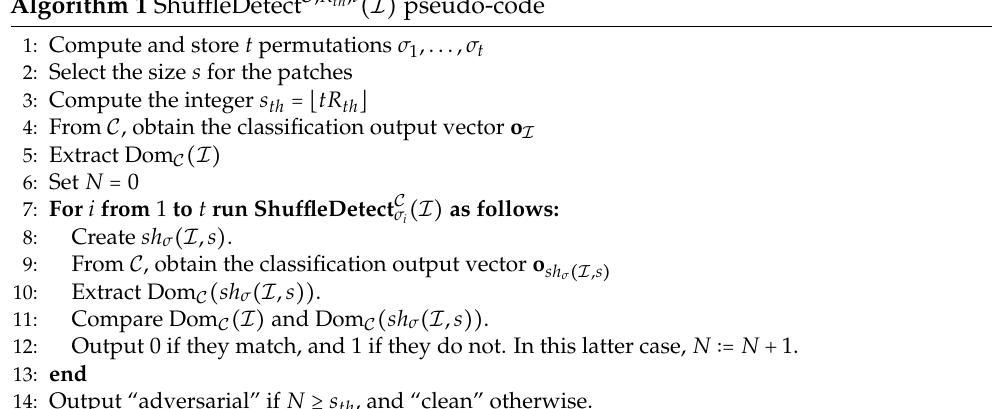
Algorithm 1 ShuffleDetect C , R th , t (I)